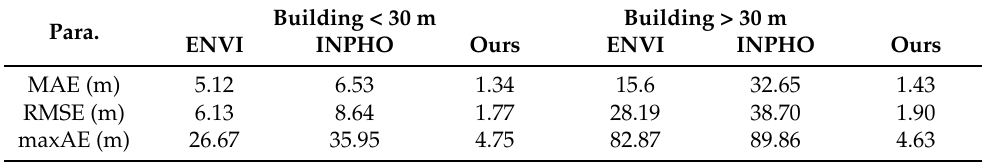
Table 6. Accuracy statistics of building roof elevation.